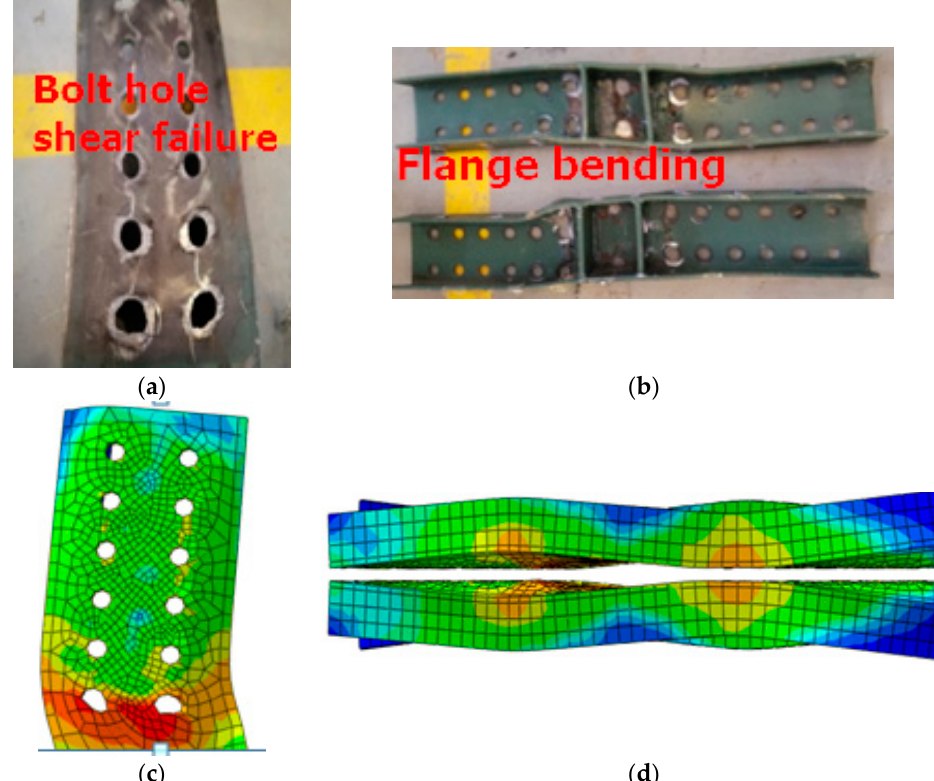
Figure 14. Test and finite element deformation comparison diagram. ( a ) bolt hole shear failure of test; ( b ) flange bending of test; ( c ) bolt hole shear failure of FEA; ( d ) flange bending of FEA.